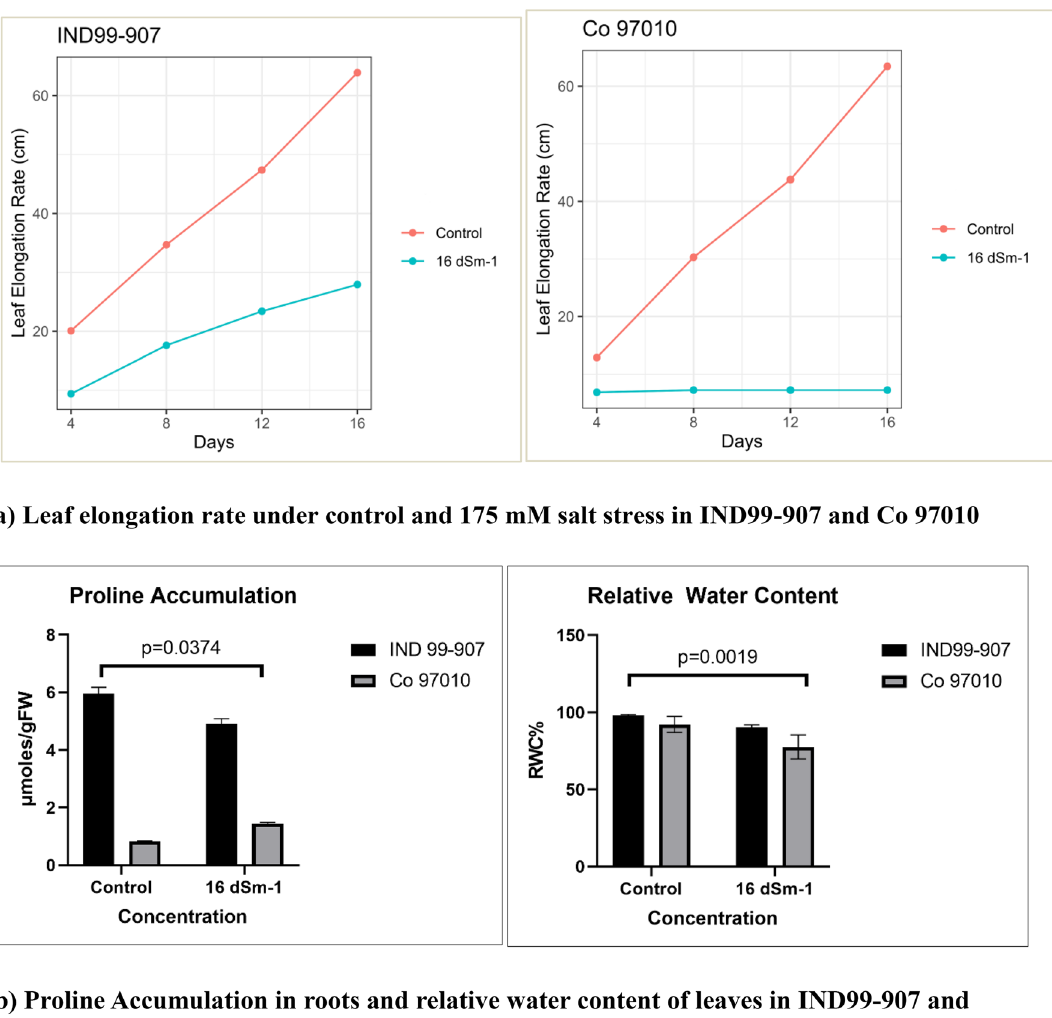
Figure 1. Phenotypic and physiological responses of IND99-907 and Co 97010 under salinity stress ( A ) Leaf elongation rate, ( B ) Proline content of roots and Relative water content in leaves. Error bars indicates the mean ±